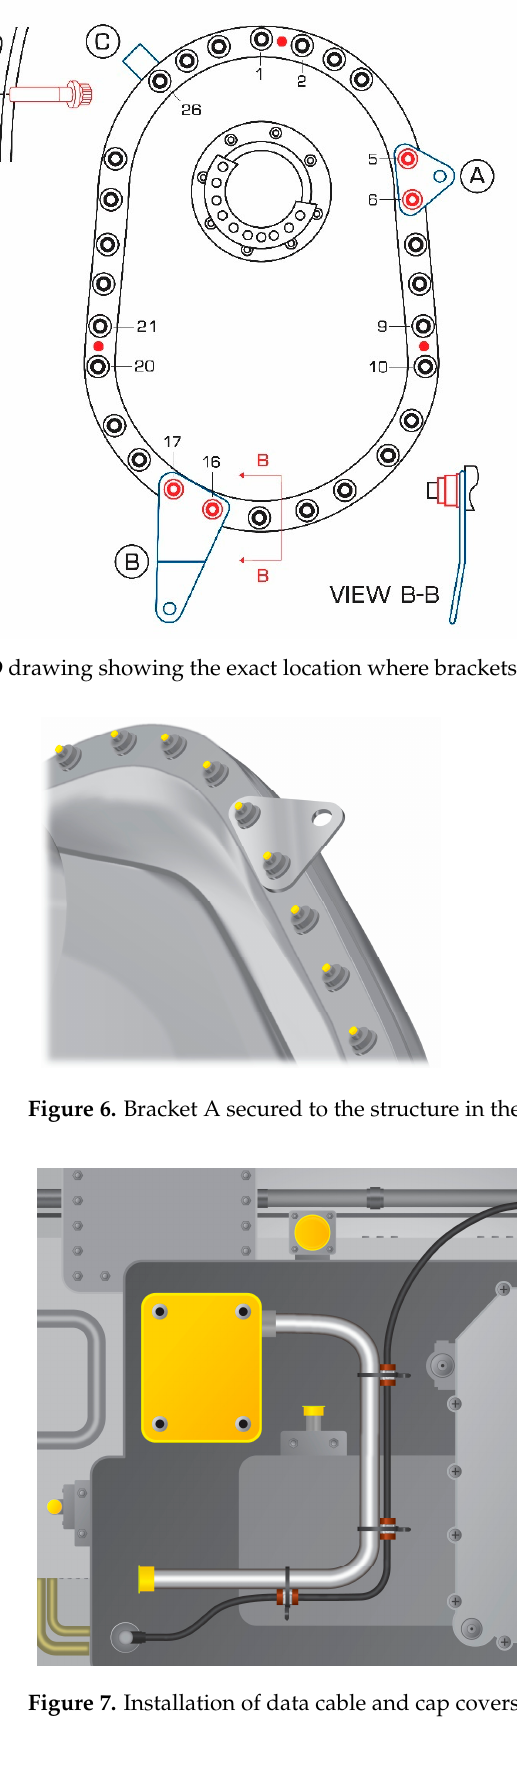
Figure 8. HTA diagram for the breakdown of the critical task No.1 (install brackets). 4.2. Identification and Description of Error Modes HTA and SHERPA techniques were applied to each task under evaluation, yielding a total of 59 identified error modes. The installation of brackets accounted for the highest number of error modes with 34 (58%), followed by the installation of cushioned loop clamps with 19 error modes (32%), and the installation of cap covers with six error modes (10%). We found errors in four of the five categories proposed by the SHERPA taxonomy: action, retrieval, checking and selection. The absence of communication errors could be explained by the limited amount of teamwork in the context under study where the nec- essary information is usually supplied to the worker electronically by the MES. For the sake of simplification and the need to avoid repeated tables, only an extract of the SHERPA output table associated with critical task No.1 (install brackets) is presented in Table 2. Similar tables were obtained as a result of SHERPA analysis of the rest of the critical tasks object of study. The consolidated results of the error modes obtained during the SHERPA analysis are presented in Table 3. Estimated cycle times are also presented at the end of Table 3 for comparison purposes. A more detailed description of each error mode is presented subsequently.